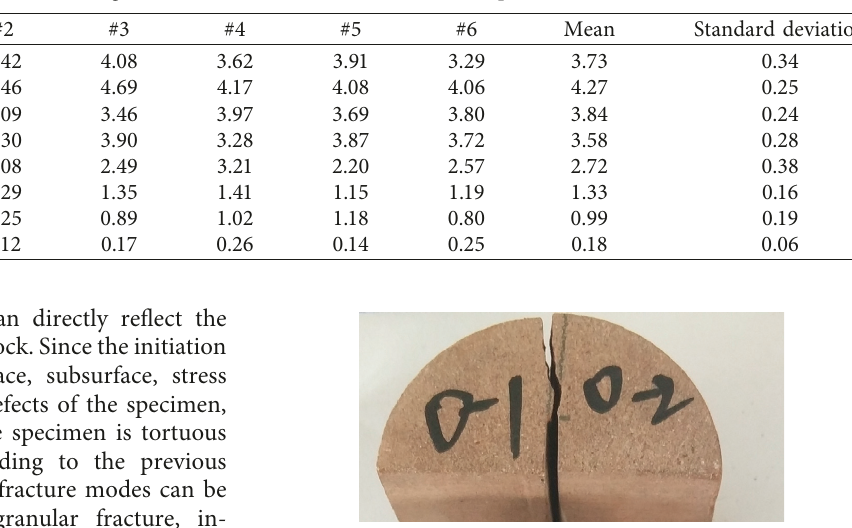
Figure 5: The relationship between temperature and the mean of fracture toughness. Table 2: Fracture toughness values of sandstone at various